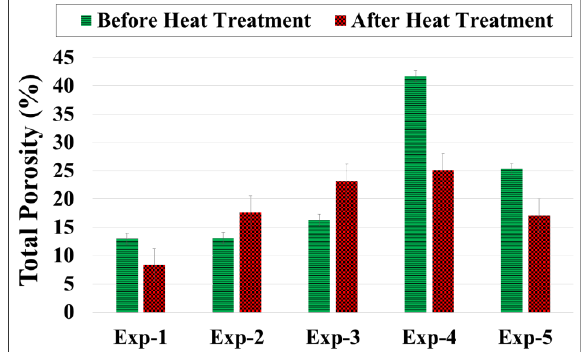
Figure 3. Total Porosity content in % area for all five coatings before and after heat treatment.